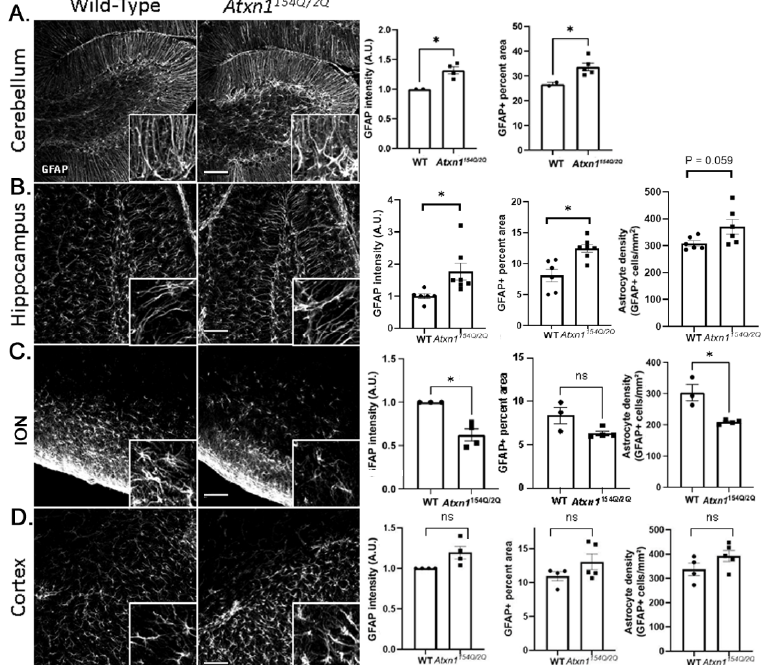
Figure 1. Spatial diversity of astrocytic morphology in Atxn1 154Q/2Q mice early in disease. Brain sec- tions from 12 weeks old Atxn1 154Q/2Q and wild-type littermate controls were stained for GFAP. Confocal images of cerebellum (( A ), lobule X), hippocampus (( B ), dentate gyrus), brainstem (( C ), ION (inferior olivary nucleus), and motor cortex (( D ), layer 6 and corpus callosum) were used to quantify GFAP intensity, density of astrocytes, and GFAP area. Images were acquired at 20× (636.16 μ m × 636.16 μ m). Scale bars show 100 μ m. Insets in the lower right corners of each image show zoomed images (79.5 μ m × 79.5 μ m) for qualitative assessment of astrocyte morphology. Data are presented as mean ± SEM with average values for each mouse represented by a dot. N = 3–7 mice of each genotype (WT and Atxn1 154Q/2Q ) as noted by dots representing individual mice in each bar graph. ns: not significant, * p < 0.05 Students t -test. These results indicate diverse morphological changes in SCA1 astrocytes across brain regions with astrocytic loss and atrophy in the brainstem, astrocyte hypertrophy in the cerebellum, and in the hippocampus and trending, but not significant astrocytic hyper- trophy in the corpus callosum.